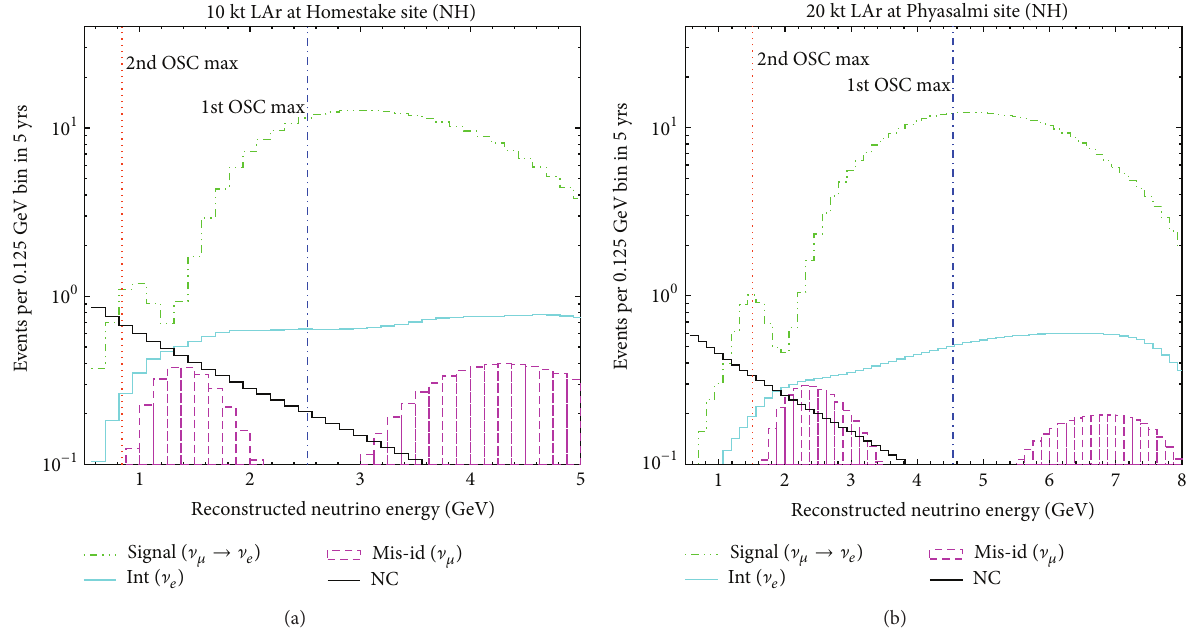
Figure 12: Expected signal and background event rates in the ] 𝑒 appearance channel as a function of the reconstructed neutrino energy including the efficiency and background rejection capabilities. Here, we consider sin 2 2𝜃 13 = 0.0975 and 𝛿 for LBNE10 (LBNO). A normal hierarchy has been assumed. In both panels, the blue dot-dashed and the orange dotted vertical lines display the locations of the first and second oscillation maxima.